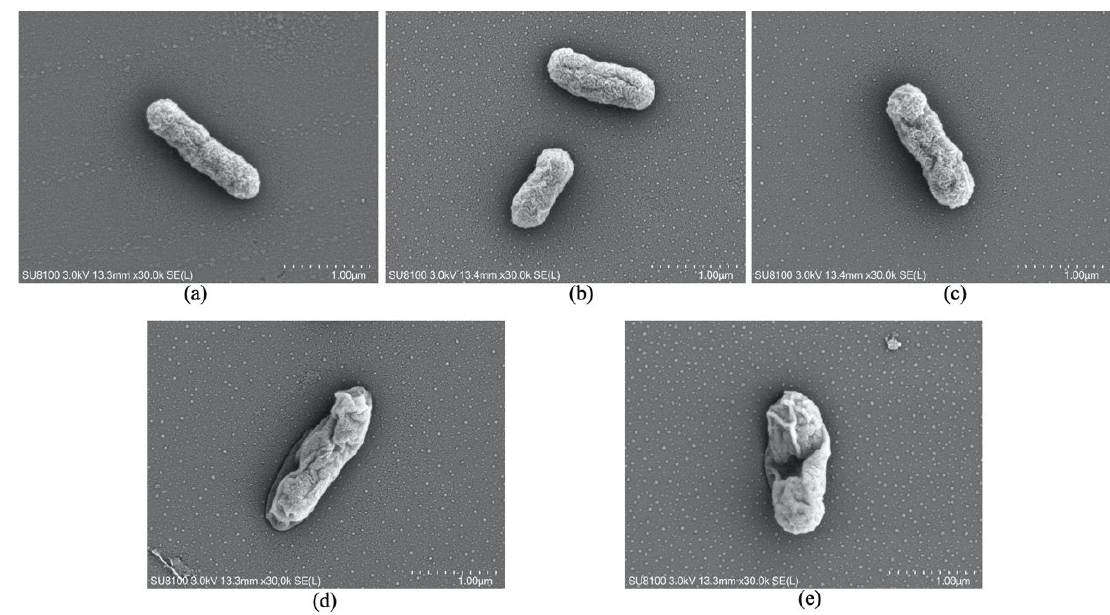
Figure 8. Field-emission scanning electron micrographs of Pseudomonas aeruginosa . ( a ) Untreated control cells at 24 h post-inoculation; ( b ) Bacterial cells treated with CAN at 1/2MIC80 (0.1 mM) for 24 h; ( c ) Bacterial cells treated with BBR at 1/2MIC80 (0.1 mM) for 24 h; ( d ) Bacterial cells treated with B+C at 1/2MIC80 (0.1 mM) for 24 h; ( e ) Bacterial cells treated with BC at 1/2MIC80 (0.1 mM) for 24 h.